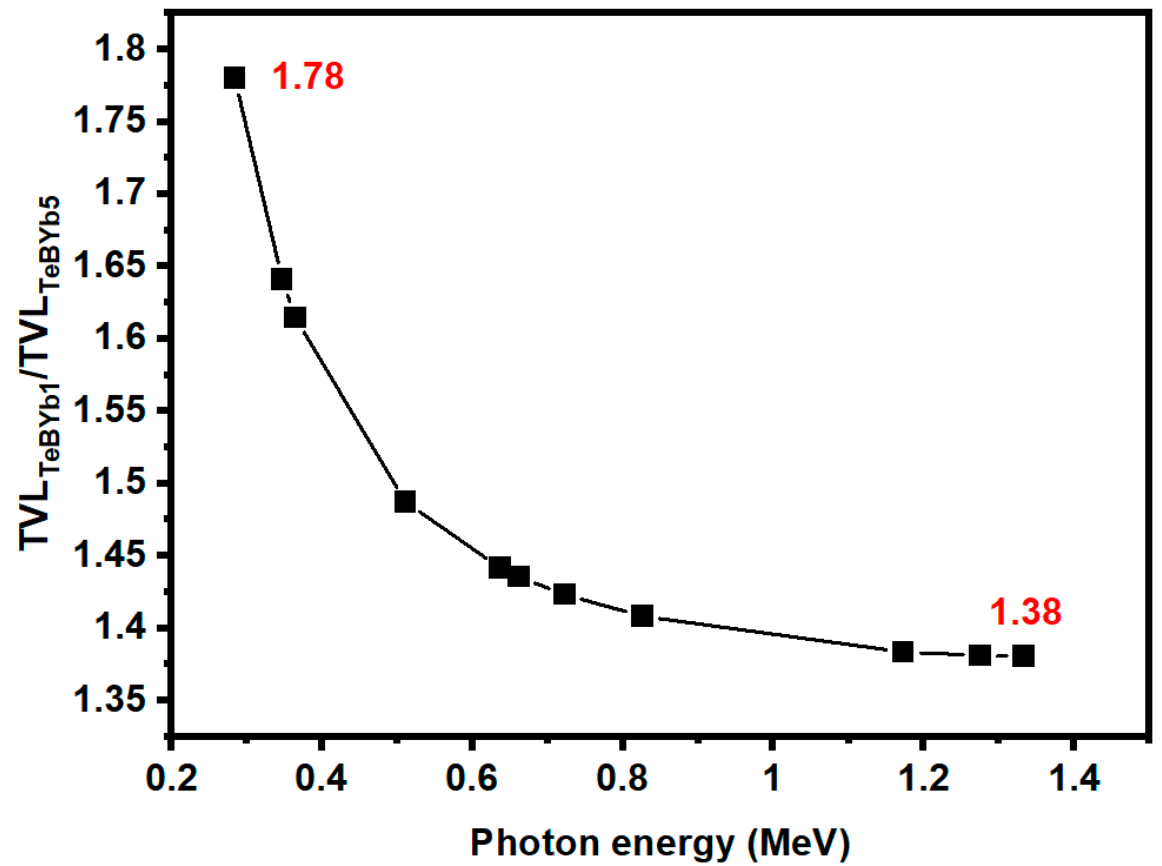
Figure 9. The ratio between the tenth value layer for TeBYb1 and that of TeBYb5. The mean free path, or MFP, was determined at 0.284 MeV and graphed in Figure 10. A smaller value is more desirable. An energy of 0.284 MeV was chosen as an example since all other energies obtained similar results. In addition to the five glass samples, the MFP of three commercial glasses and one concrete were plotted at the same energy for comparison, namely Rider, RS-360, PHP, and ordinary concrete. The results demonstrated that the five Yb 3+ -doped calcium borotellurite glasses had a lower MFP than Rider and PHP glass and ordinary concrete, with Rider having the greatest MFP at 4.44 cm, which indicates that the investigated glasses have greater shielding capabilities than the other three materials. However, RS-360 has the lowest MFP out of all the tested materials at 1.10 cm, which means it is a better shield than the Yb 3+ -doped calcium borotellurite glasses. When only comparing these glasses, TeBYb5 has the lowest MFP at 1.45 cm, while TeBYb1 has the greatest at 2.59 cm. The figure indicates that as the TeO 2 content in the glasses increases, and the density with it, the MFP decreases, improving the shielding abilities of the glasses. This trend is consistent with the other investigated parameters. From this graph, it can be concluded that TeBYb5 and RS-360 have the greatest potential to be used in radiation shielding applications.